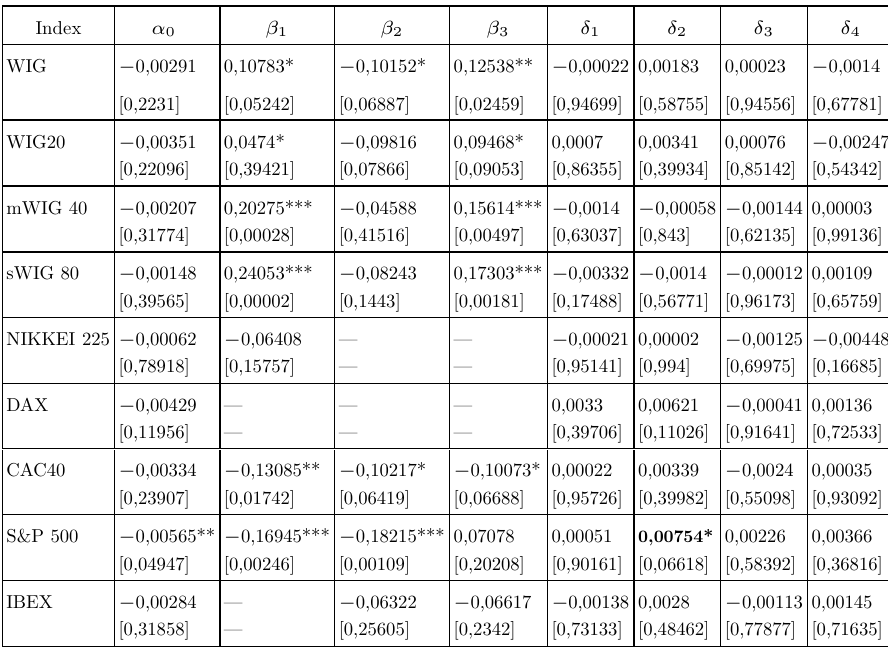
Results for the period: November 2007 – February